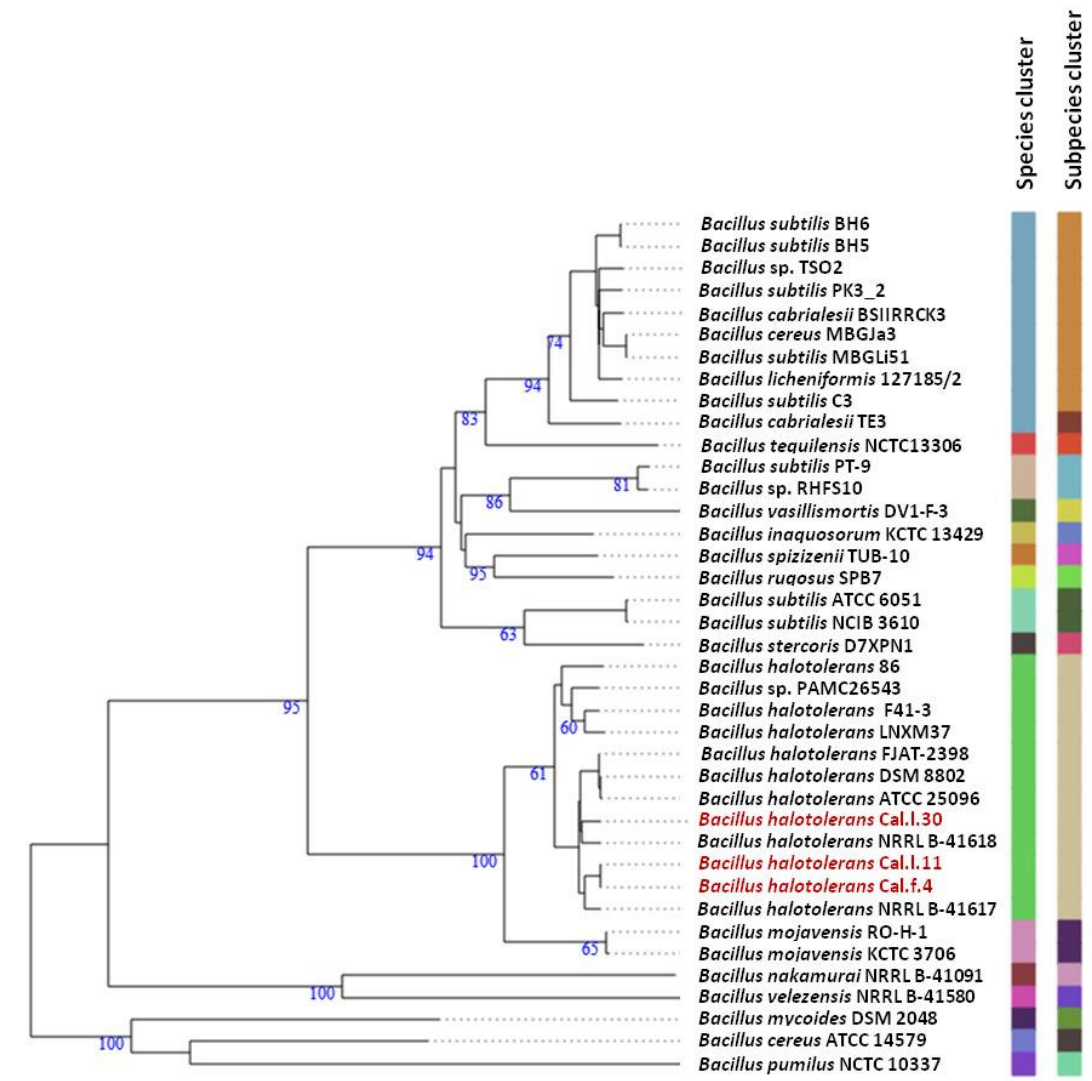
Figure 3 . Whole genome phylogenomic tree of Bacillus strains closely related to B. halotolerans strains Cal.l.30, Cal.f.4 and Cal.l.11, constructed using the type (strain) genome server—TYGS. The numbers at the branches are pseudo-bootstrap support values inferred from 100 replicates. The two colored columns to the right of each name refer to the genome-based species and subspecies clusters, respectively, as determined by dDDH cut-off of 70 and 79%, respectively. B. halotolerans strains Cal.l.30, Cal.l.11 and Cal.f.4 are highlighted in red.